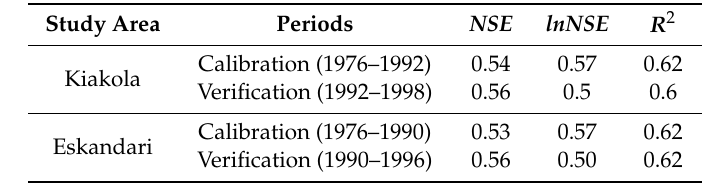
Table 3. Hydrological modelling results.